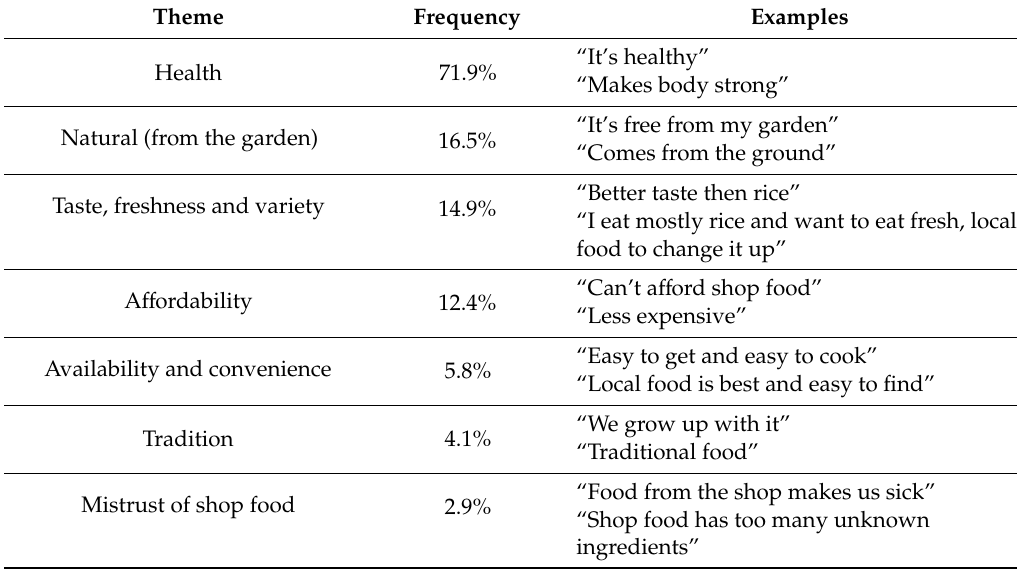
Table 5. Conventional content analysis for local food preference, including common themes and two examples of why from each